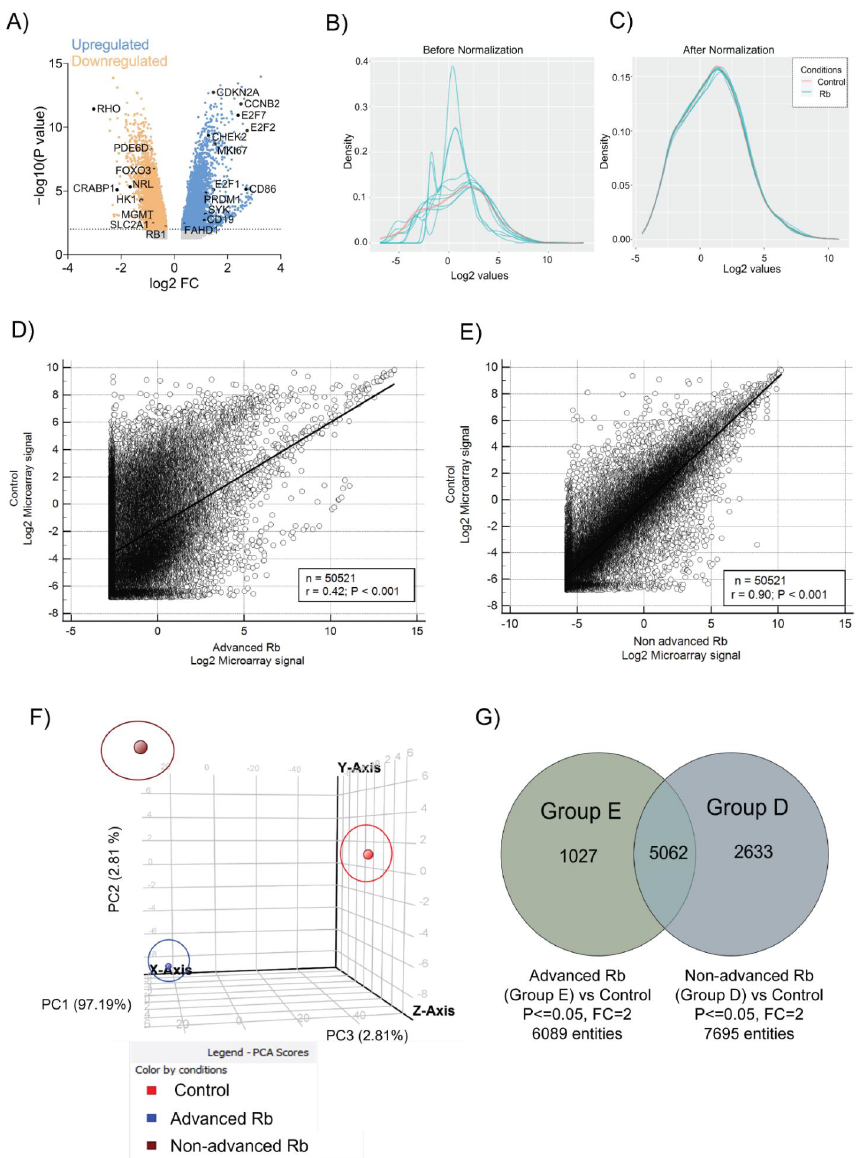
Figure 1. Identification of distinct transcriptional signatures in advanced and non-advanced Rb tumors from primary enucleated eyes. ( A ) Volcano plot of differentially expressed genes. Density curve plot showing the overall signal distribution of all probe sets on the microarray. ( B ) Before nor- malization. ( C ) After normalization. Spearman’s correlation analysis of genes detected in microarray platform across: ( D ) Control vs. Advanced Rb (r = 0.42, p < 0.001); ( E ) Control vs. Non-advanced Rb (r = 0.90, p < 0.001. ( F ) Principal component analysis on the microarray results shows distinct clusters, implicating gross differences between the advanced Rb, non-advanced Rb, and the controls. ( G ) Venn diagram showing differential genes identified in Group E (advanced) and Group D (non-advanced) Rb tumor microarrays compared to pediatric